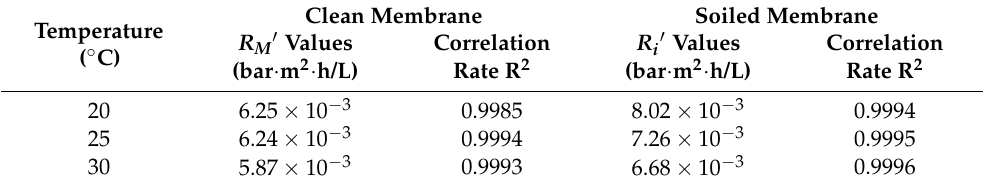
Table 6. Clean and soiled membrane resistances at different